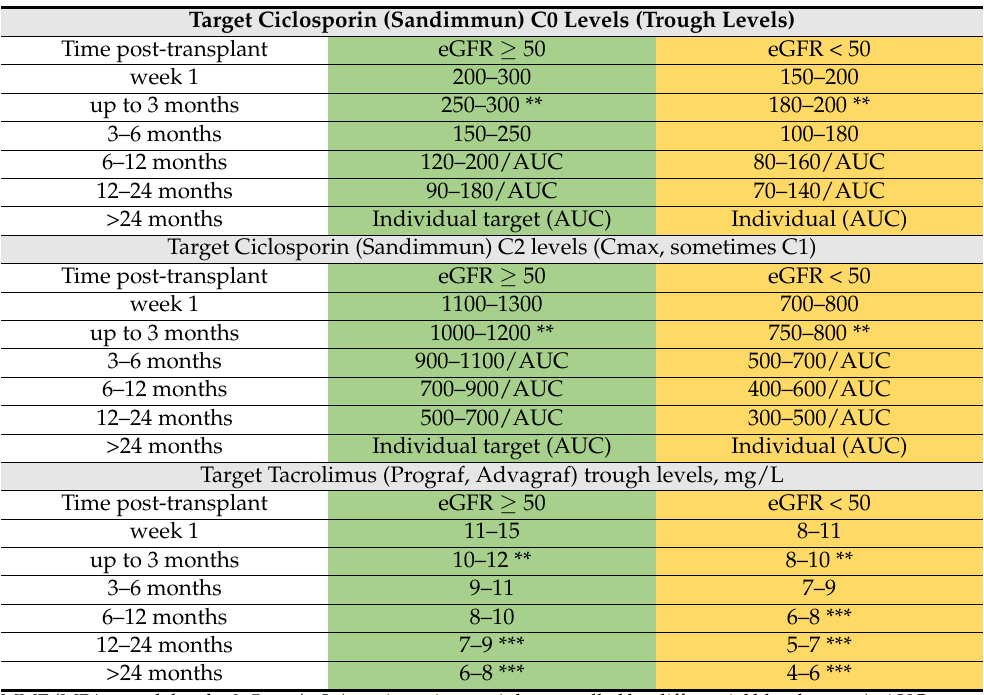
Table 1. Therapeutic drug monitoring target